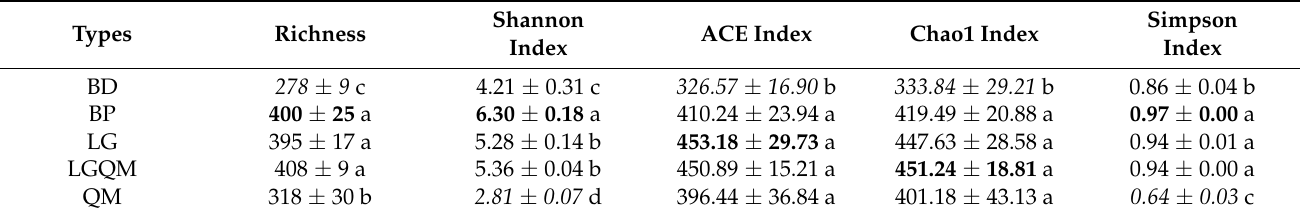
Table 3. Alpha diversity of the soil fungi in the forest types examined herein.